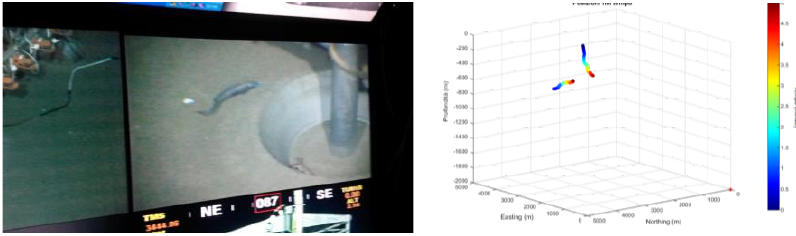
Figure 2. Left: Fishes and crabs colonising a subsea JB of KM3NeT ARCA, observed during ROV video footage. Right:3D-reconstruction (Easting, Northing, depth) of the dive of 2 sperm whales detected by O  DE, The color scale indicate time of detection in a 5 min long acquisition.